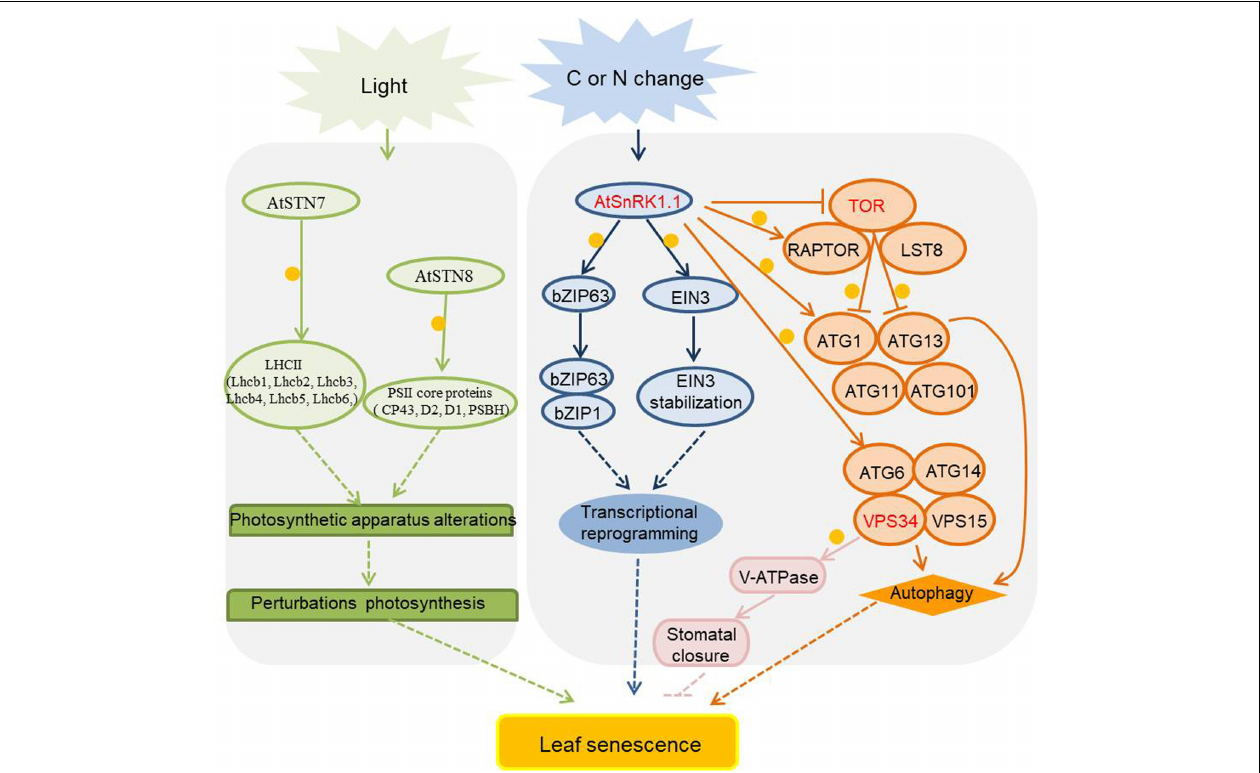
FIGURE 5 | Energy and metabolism related kinases in the regulation of leaf senescence. As metabolite, carbon (C) and nitrogen (N) assimilates are transported from source organs to sink organs, and the nutrient balance of carbon and nitrogen plays an important role in signaling transduction during leaf senescence. The activities of protein kinases are affected by sugar and nitrogen signals and participate in the aging process of plants, and they are marked in red, orange circles indicate phosphorylation. Arrows show that the process is promoted, and T-bars mean the process is inhibited. The activity of SnRK1 is induced by starvation, and it phosphorylates some transcription factors to regulate SAGs expression or to induce the autophagy process by phosphorylating ATG1 and ATG6. SnRK1 also phosphorylates RAPTOR to inhibit the TOR’s activity. TOR negatively regulates autophagy process by phosphorylating ATG1 and ATG13 to inhibit the initial formation of autophagosomes. The PI3K protein VPS34 phosphorylates V-ATPase to activate stomatal acidification and promote stomatal closure during JA-induced leaf senescence. STN7 and STN8 maintain the balance of photosystems by phosphorylating PSII core and LHCII protein, when the phosphorylation status changed drastically, the balance would be disturbed and the leaves would senescence. STN7/8, state transitions 7/8; PSII, Photosystem II; LHCII, light-harvesting complex II; SnRK1, sucrose non-fermenting 1 related protein kinase 1; EIN3, ethylene-insensitive 3; TOR, target of rapamycin; RAPTOR, regulatory-associated protein of mTOR; LST8, lethal with SEC13 protein 8; PI3K, phosphoinositide 3-kinase; ATGs, autophagy-related proteins; VPS34, vacuolar protein sorting 34; VPS15, vacuolar protein sorting 15; V-ATPase, vacuolar H +